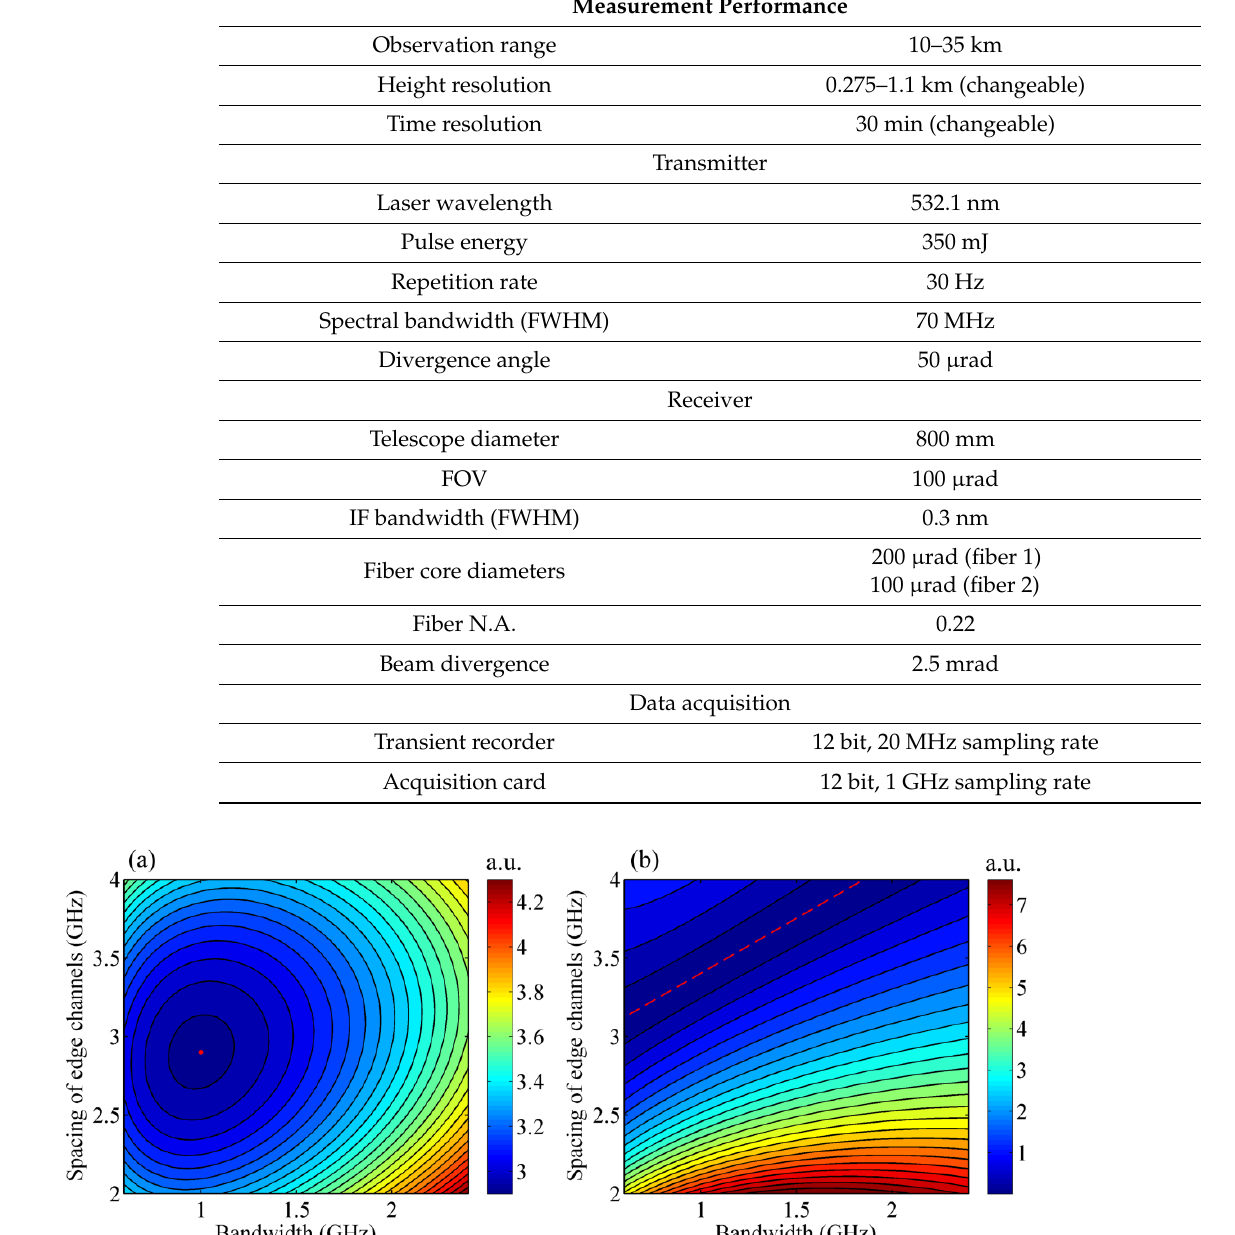
Figure 4. Simulated ( a ) random errors of VOS and ( b ) VOS errors caused by Mie signals with respect to different bandwidths and spacing of edge channels. A red dot or dotted line marks the optimized parameters.